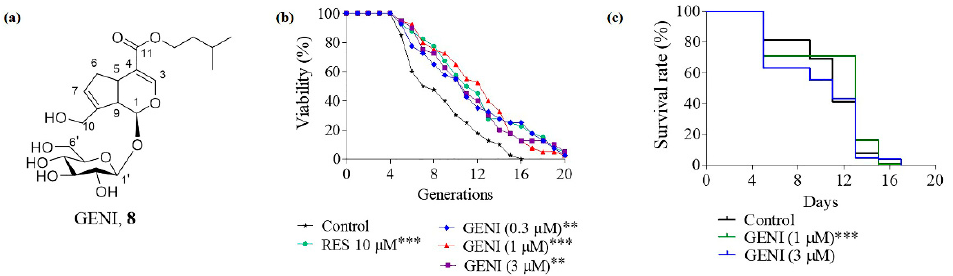
Figure 2. The effect of GENI on the replicative lifespan and chronological lifespan of yeasts. ( a ) The structure of GENI. ( b ) Effect of GENI on the replicative lifespan of K6001 yeast. RES at 10 µM was used as the positive control. ( c ) Effect of GENI on the chronological lifespan of K6001 yeast. Experiments were repeated thrice, and the data are presented as means ± SEM. ** p < 0.01 and *** p < 0.001 represent significant difference compared with the control group.